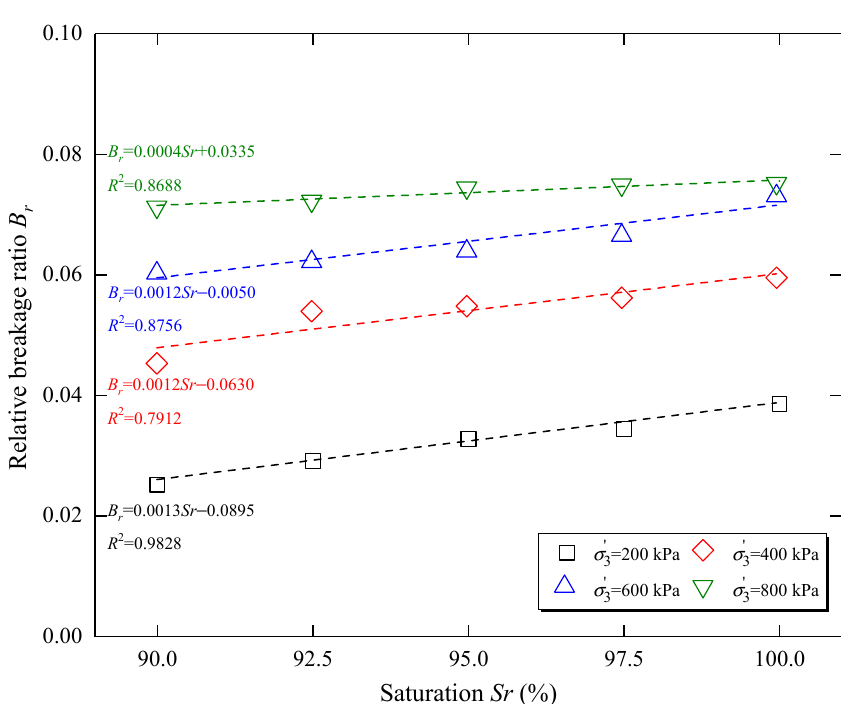
Figure 15. Relationship between relative breakage ratio and saturation of coral sand.